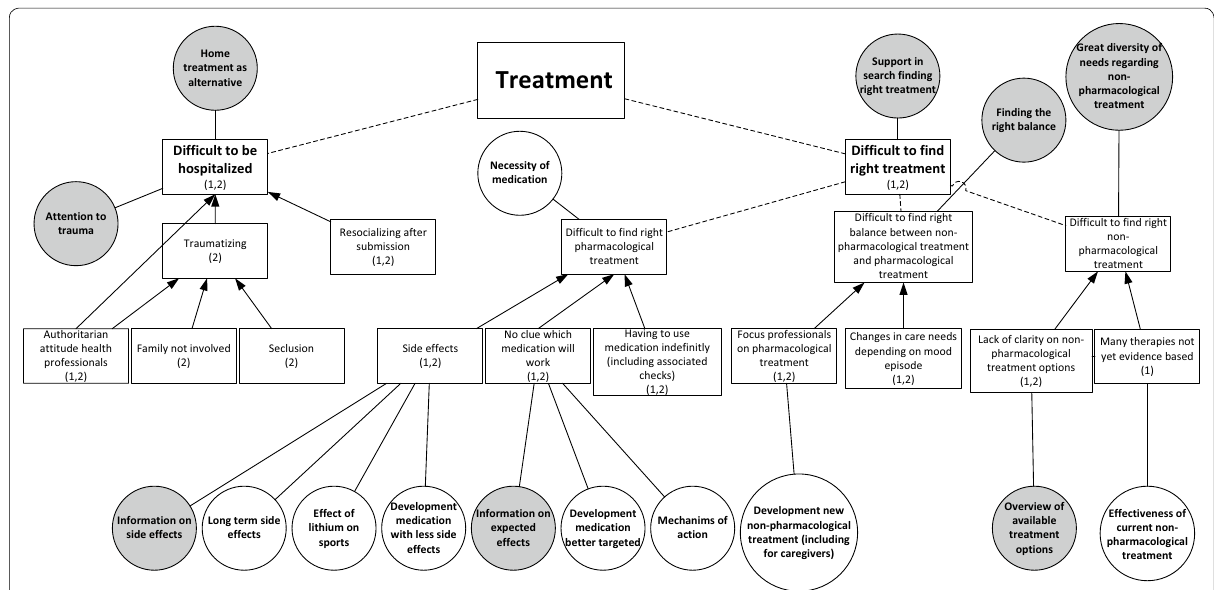
Fig. 2 Challenges with treatment (squares) including relating research needs (white circles) and care needs (grey circles). (1): mentioned in study on research needs; (2): mentioned in study on care needs. Dotted lines: division of challenges into sub challenges. Arrows: causal relation between